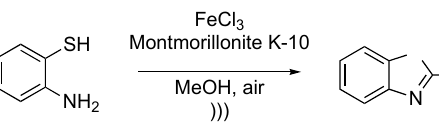
Scheme 23. Synthesis of 2-substituted benzothiazoles catalyzed using FeCl 3 /Montmorillonite. The